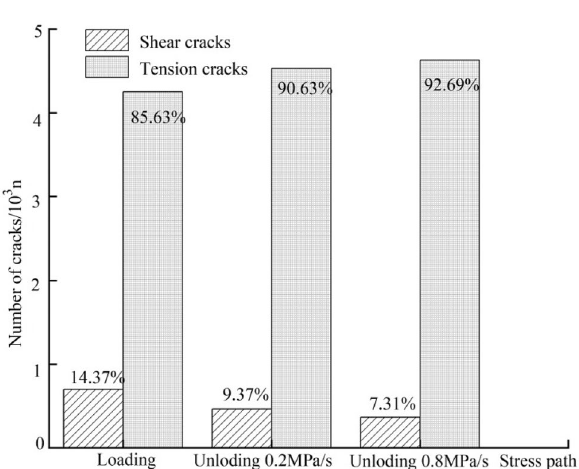
Figure 8. Bar graph of the number of cracks at different unloading rates of confining